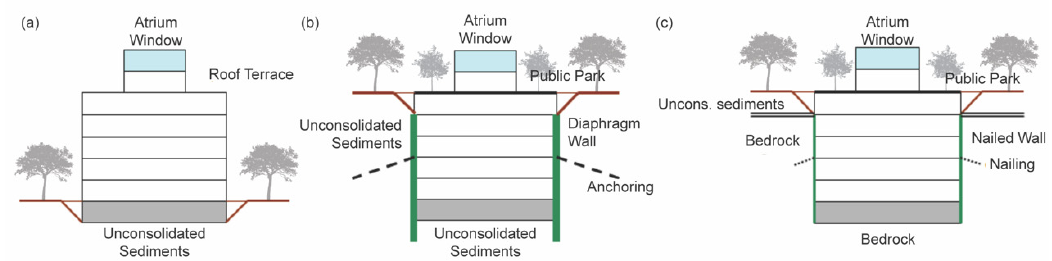
Figure 1. Three variants: Surface option ( a ), underground option in less favorable conditions (unconsolidated sediments) ( b ), underground option in more favorable conditions (bedrock) ( c ), adapted from Poux 2008, p. 11. Table 1. Technical details of the three commercial variants (adapted from Maire 2011, p. 115) Construction